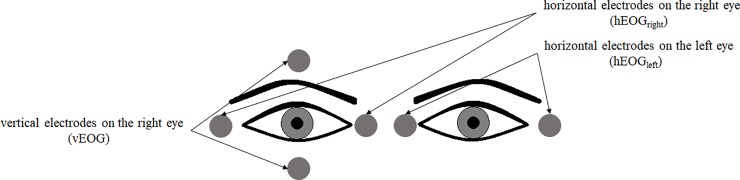
Electrode placement for EOG data collection.First, the saccade signal was registered separately for left and right eyes. Subsequently, they were averaged using the following formula: EOGsacc = (hEOGleft + hEOGright)/2.